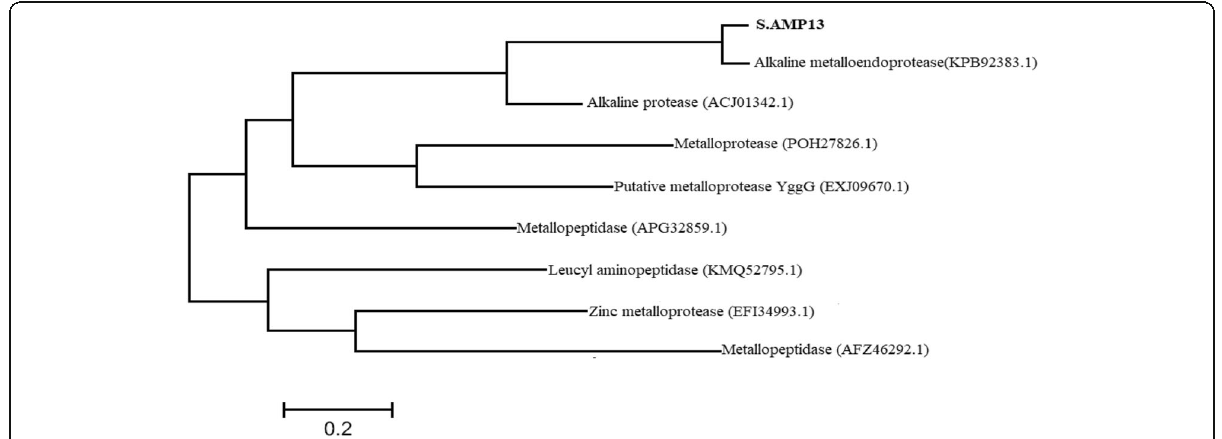
Fig. 11 Phylogenetic tree analysis of S.AMP13 with other